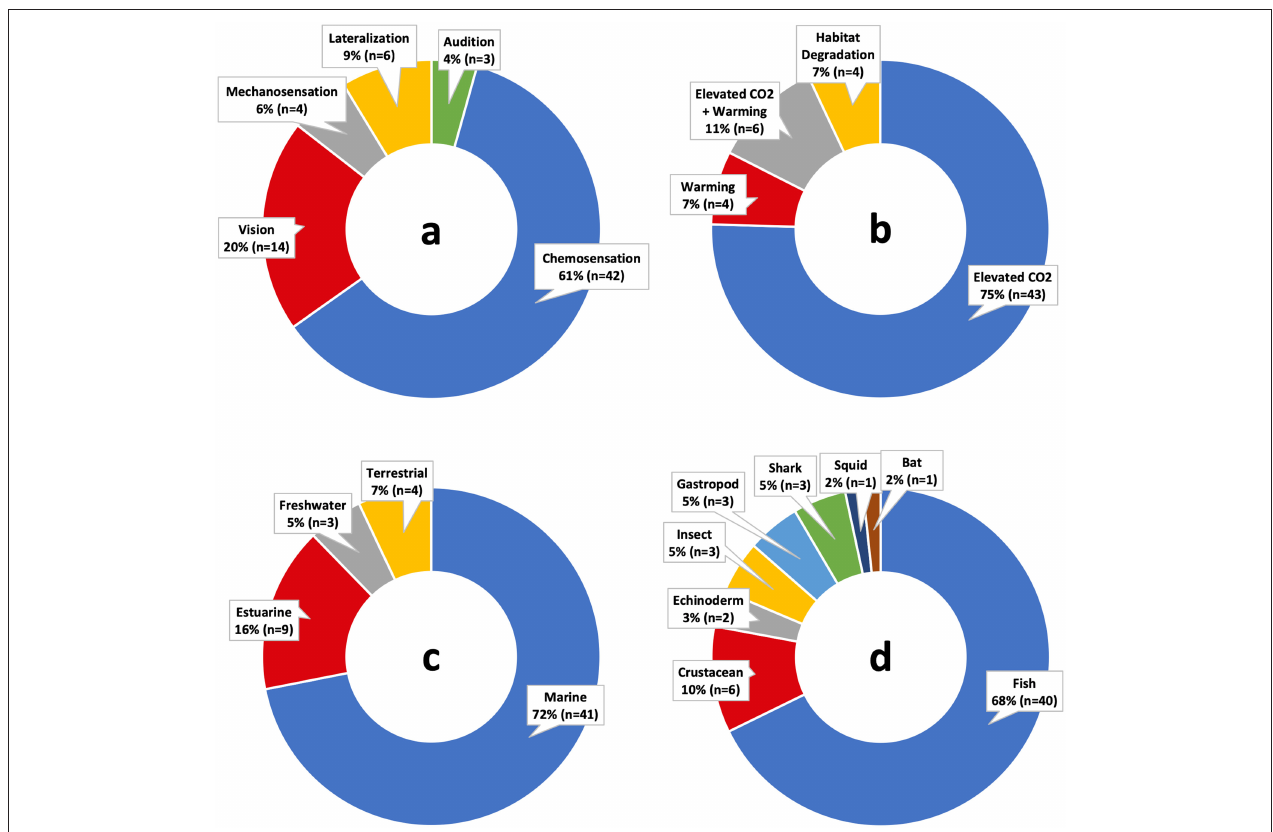
Warming Elevated CO 2 System Terrestrial Freshwater Marine Terrestrial Freshwater